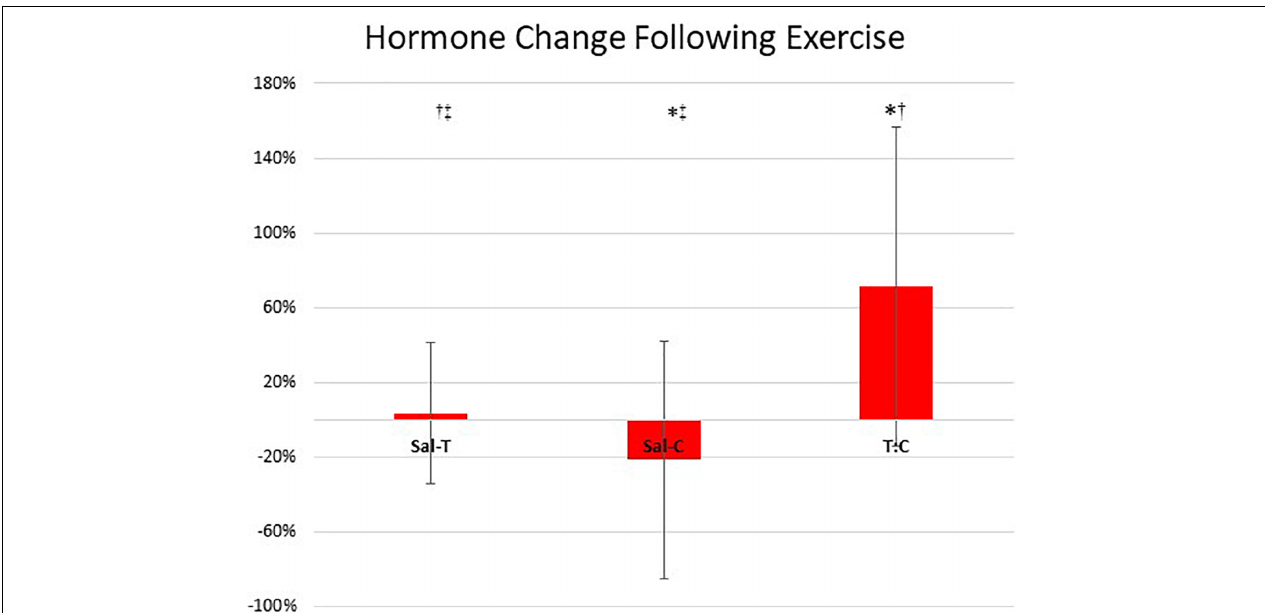
FIGURE 1 | Study 1 hormone responsiveness to gym-based speed, power, and strength session as a proportion of pre-training values (mean ± standard deviation). Sal-T, salivary testosterone (pmol/L); sal-C, salivary cortisol (nmol/L); and T:C, testosterone to cortisol ratio [i.e., sal-T (pmol/L) divided by sal-C (nmol/l)]. *Significantly different to sal-T ( p < 0.05). † Significantly different to sal-C ( p < 0.05). ‡ Significantly difference to T:C ( p < 0.05). No statistically significant relationships were observed for hormone responsiveness and digit ratios.